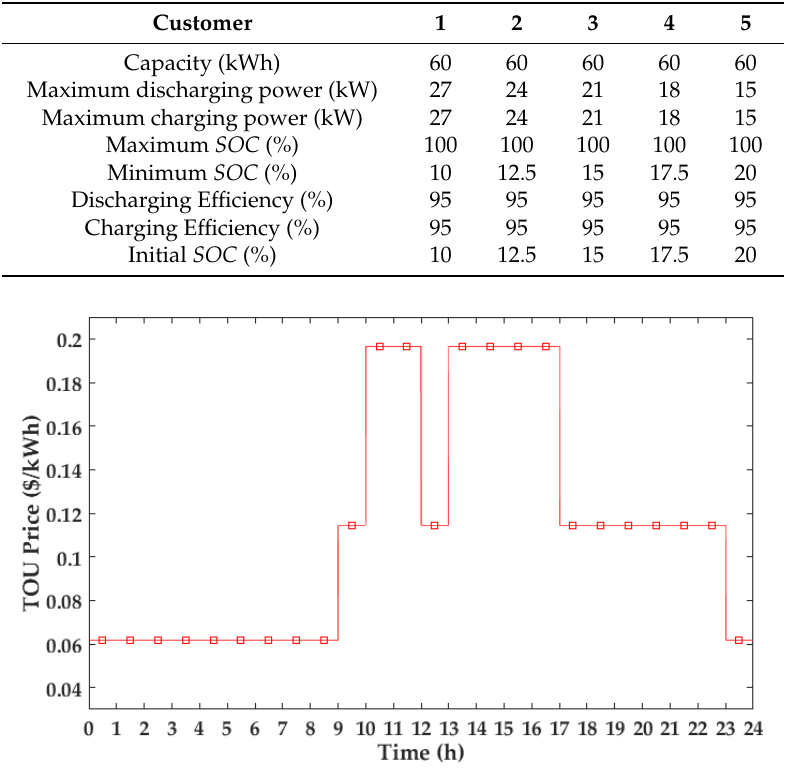
Figure 5. TOU tariff in summer.